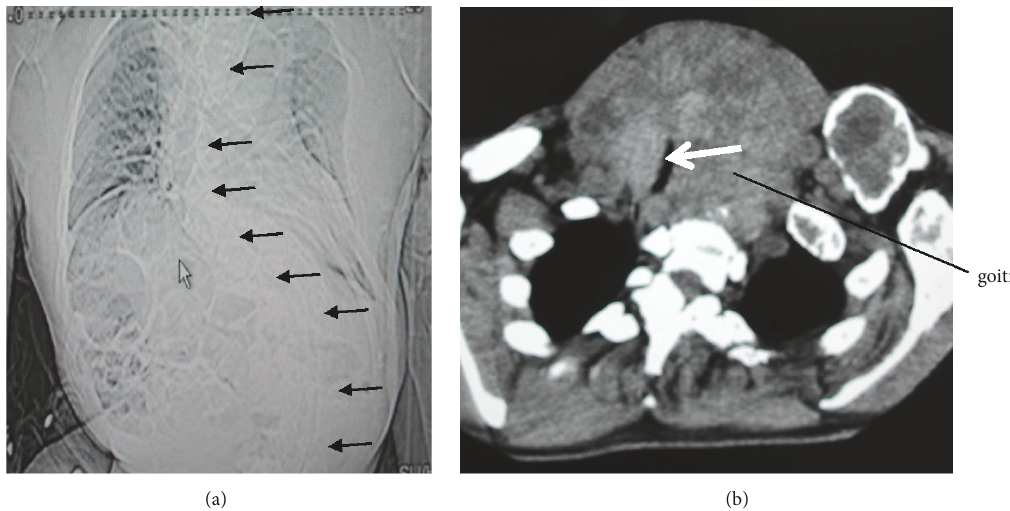
Figure 1: Preoperative CT scan. (a) Lateral curvature of the spine. (b) Narrowest portion of the trachea was 4 mm in diameter in lying down.